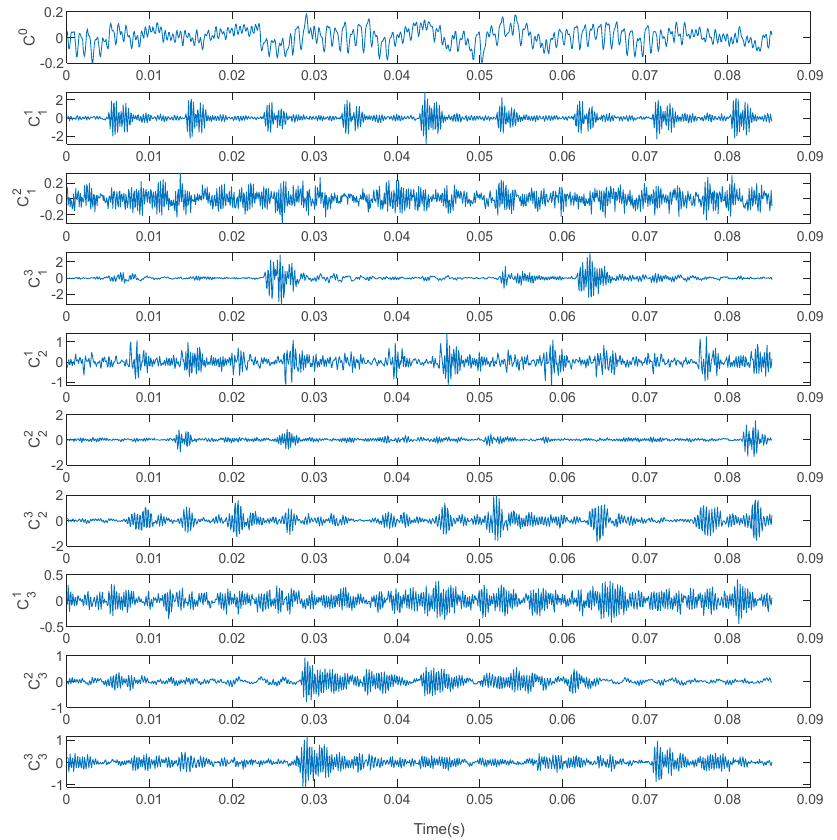
Figure 6. Raw signal of rolling bearing vibration under different failure modes.